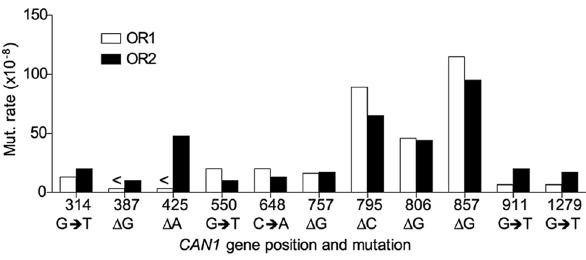
Figure 5. Comparison of CAN1 mutation rates at hotspots (predominant mutation at site) in rnr1-Y285A strains with natural (OR1) and reversed (OR2) orientation of the CAN1 gene. , Denotes that no events were detected.